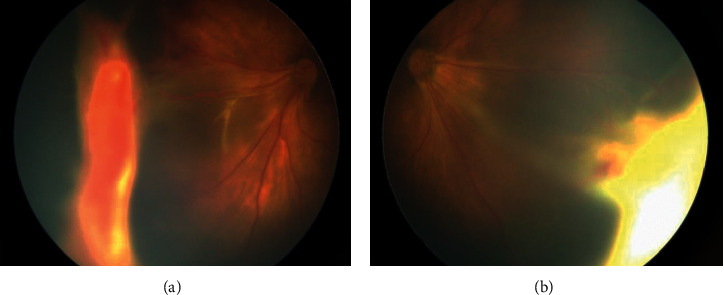
Colour fundus of case 2. (a) Right eye. (b) Left eye. Both eyes were stage 4a accompanied by macular dragging.